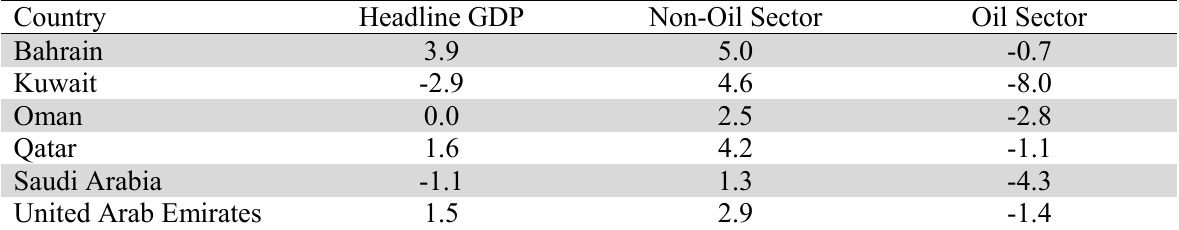
Economic diversification of GCC